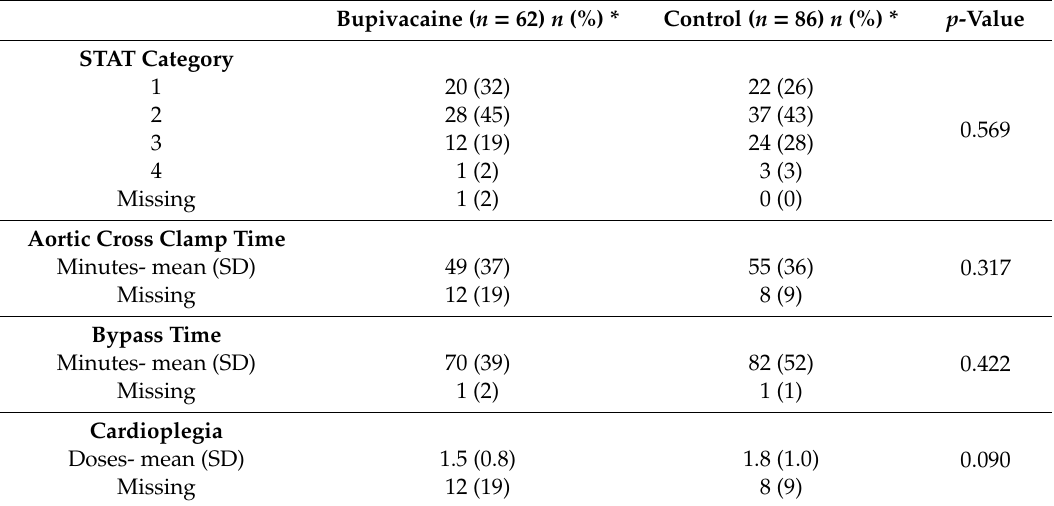
Table 4. Patient operative